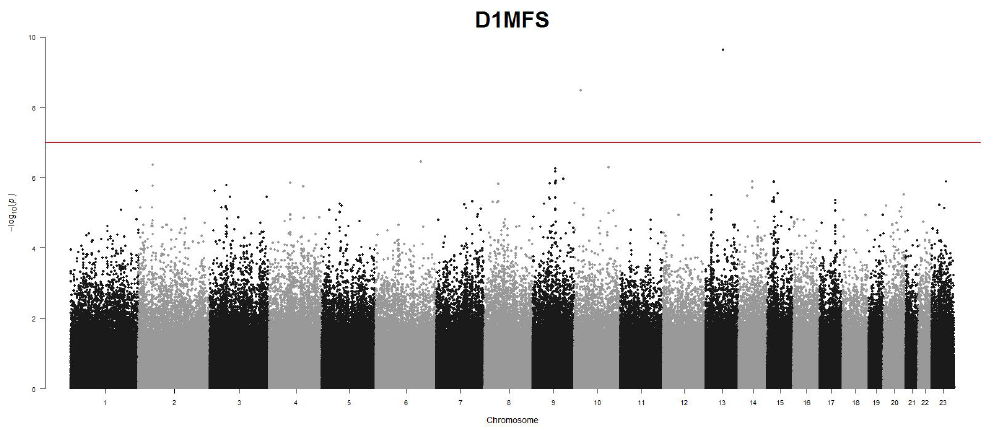
Figure 10. Genome-wide scanning for trait D1MFS using single-marker association tests based on ZINB